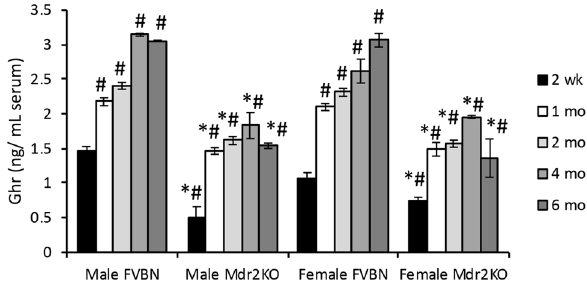
Figure 1. Time-course of serum Ghr in Mdr2KO mice vs FVBN controls. Male and female mice from two weeks to six months old were tested for circulating Ghr by EIA. Number of animals, 4; number of serum sample replicates in ELISA test, 3; p < 0.05. *, Mdr2KO vs FVBN mice. #, all mice older than two weeks vs two week old, male FVBN